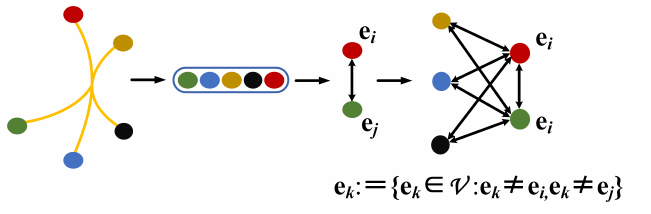
Figure 4. An illustration of transforming the hyperedge into a simple graph, where the key nodes e i and e j (i.e., the two nodes with the greatest difference) are selected from the hyperedge, and the remaining nodes e k in the hyperedge are connected with the key nodes to form a new simple